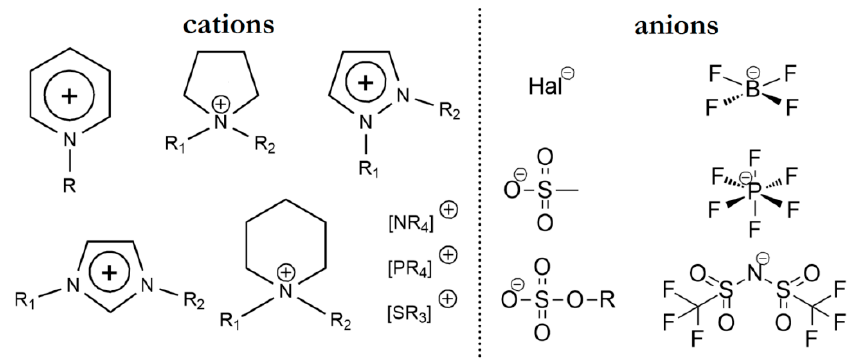
Figure 1. Commonly used ILs cations and anions, where [NR 4 ], [PR 4 ] and [SR 3 ] represent different structures of ammonium, phosphonium and sulphonium respectively, and Hal − represent the halogens group. Table 1. Melting temperature ( T m ) of common inorganic salts in comparison to ILs based on